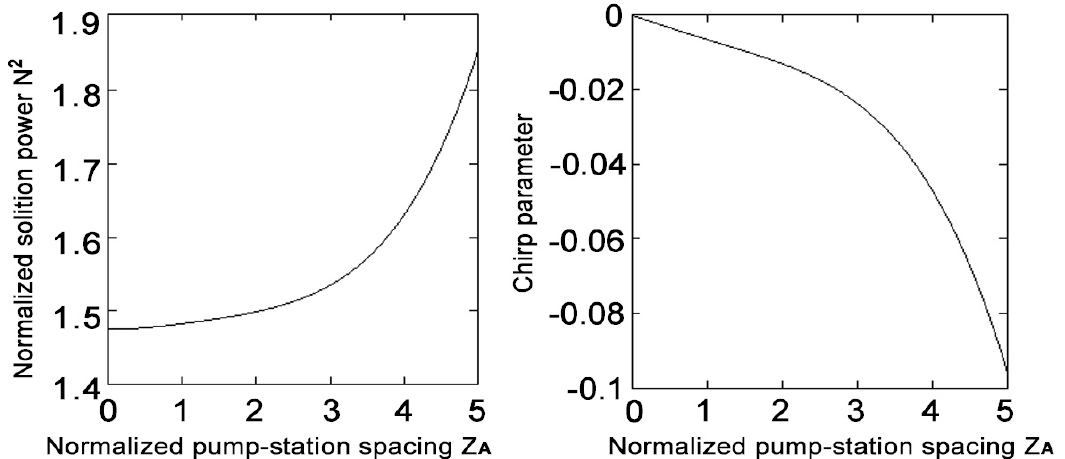
Figure 3. Normalized input peak power and chirp of soliton as a function of normalized pump–station spacing z A numerically obtained from Method of Moments when consecutive pumping stages are separated by 40